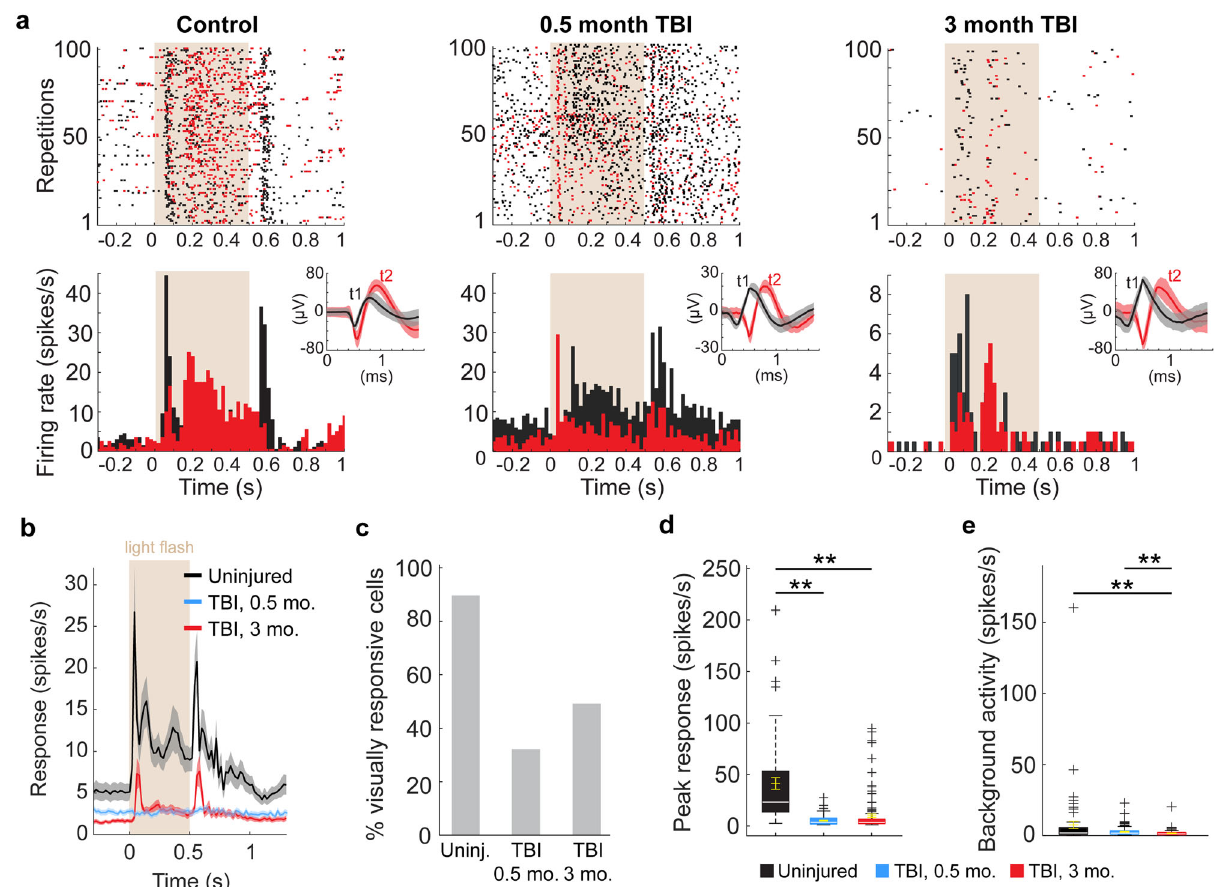
Fig. 6 Reduced V1 neuron fi ring following TBI. a Light-evoked responses of action potential fi ring for two example neurons (black and red) for each animal group: control (left), 0.5 months (middle) and 3 months after injury (right). The top row shows raster plots to 100 repetitions of the fl ash stimulus. The bottom row shows the spikes/s averaged over 20 ms bins. In both rows, the 500 ms light stimulus is indicated by beige background shading. Insets in the upper right of the bottom row show raw wave forms isolated by two templates (t1, black and t2, red) based on differences in spike amplitude (uV) and timing (ms). Shading indicates spike variability. b Population averages of light-evoked single-unit responses of action potential fi ring in uninjured controls (black) and CCI-injured mice 0.5 months (blue) and 3 months after injury (red). n = 67 cells from 8 controls, 110 cells from 5 mice 0.5 months after TBI, and 115 cells from 5 mice 3 months after TBI. Shading indicates S.E.M. The 500 ms light stimulus is indicated by beige background shading. c . Percentage of visually responsive cells. d Quanti fi cation of peak single-neuron fi ring rates from each group in response to light stimulus. ** P = 9.56E-10, control versus 0.5 months after TBI, ** P = 9.56E-10, control versus 3 months after TBI; Kruskal – Wallis H with Dunn ’ s post hoc. e Quanti fi cation of single-neuron fi ring rates from each group in the 500 ms prior to the light stimulus. * *P = 2.00E-03, control versus 0.5 months after TBI, **P = 3.02E-04, control versus 3 months after TBI; Kruskal – Wallis H with Dunn ’ s post hoc. For box plots, dashed error bars represent the maximum and minimum observations within